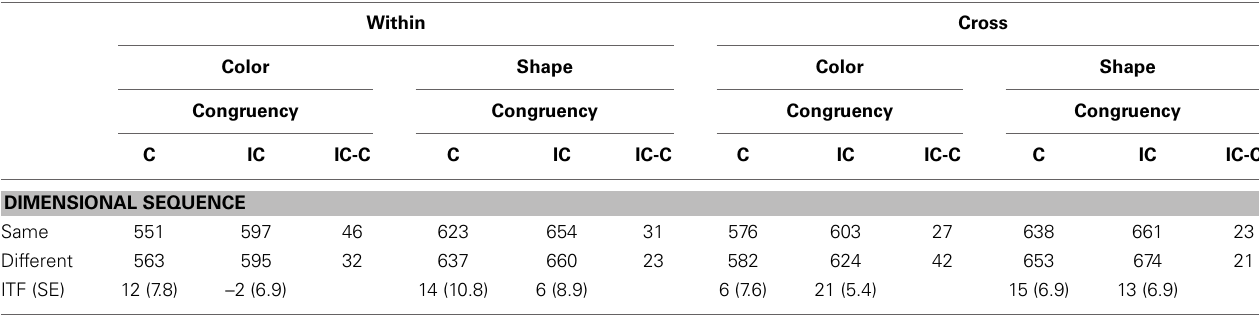
Table 6 | Mean correct reaction times in trial n as a function of the dimensional sequence of target-defining feature with trial n − 1 and the response congruency of trial n in Experiment